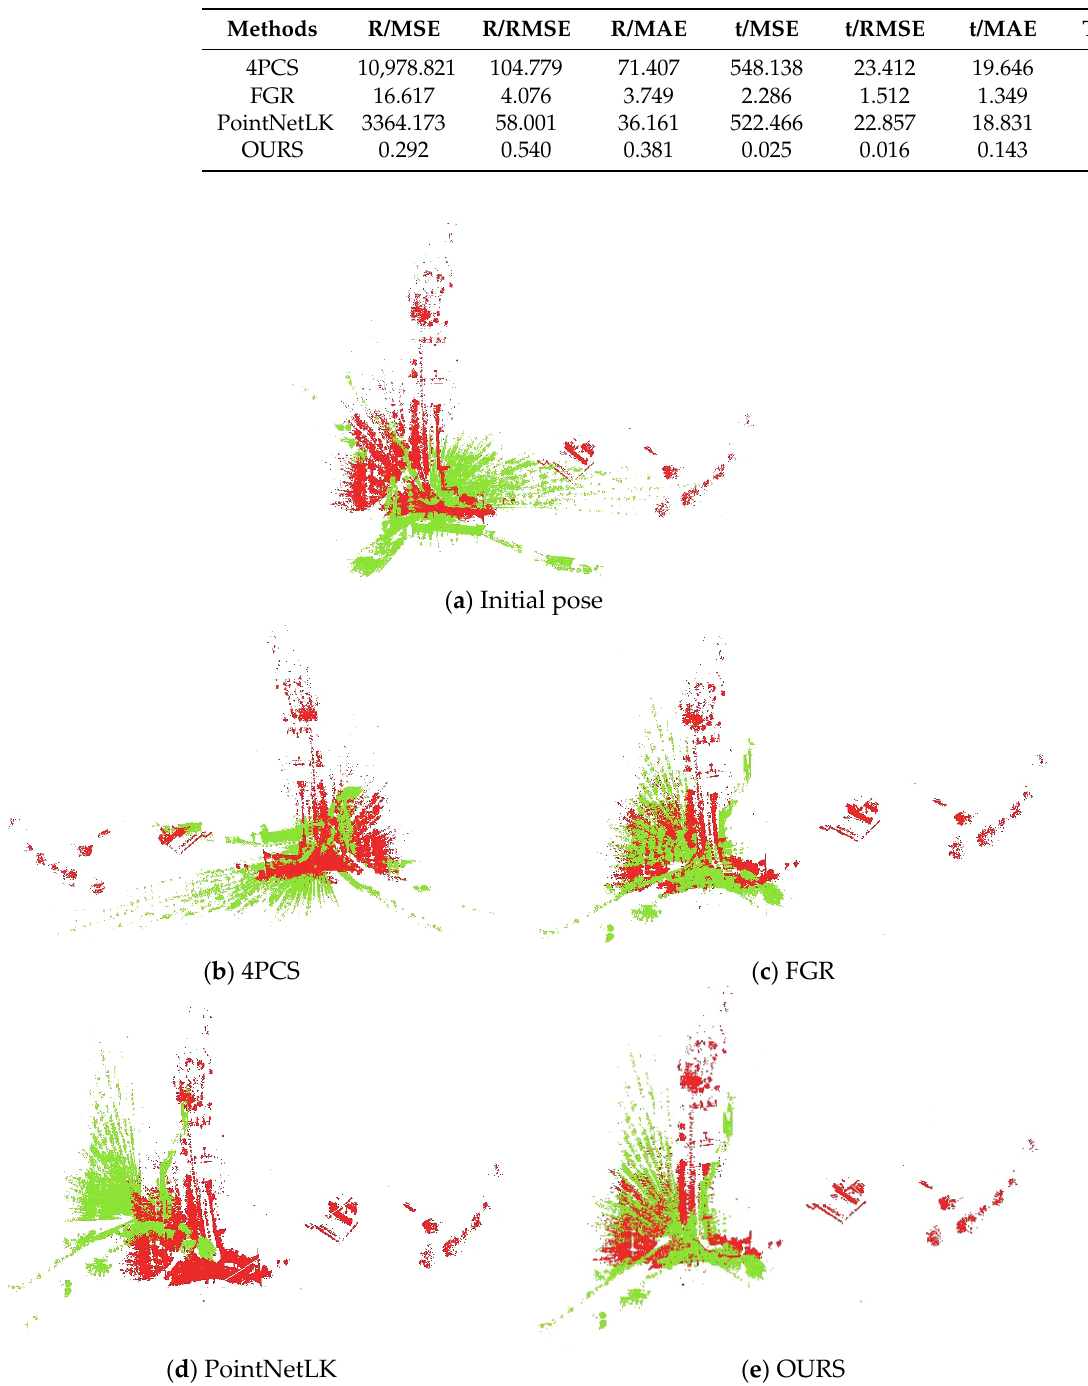
Table 8. Registration error and time of different methods for park scenes.